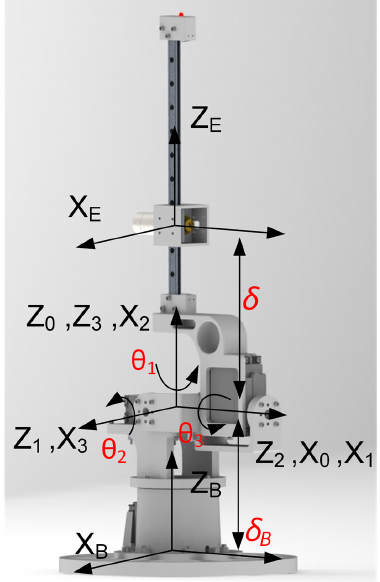
Figure 3. Frame assignments of the proposed robotic